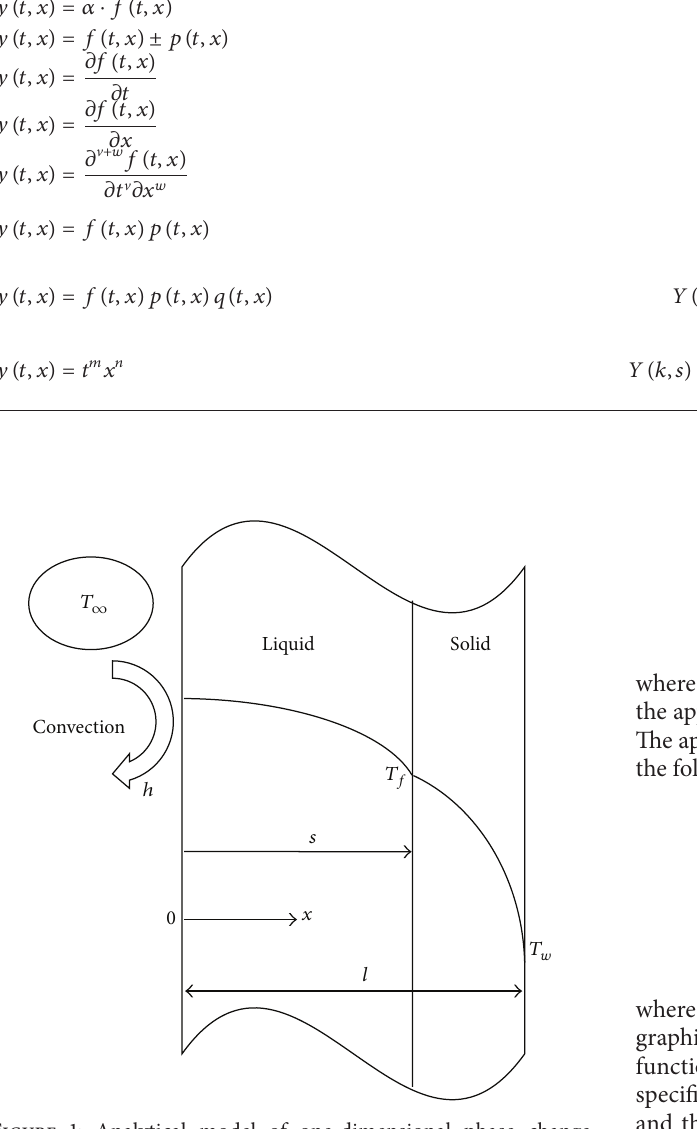
Figure 1: Analytical model of one-dimensional phase change process for a finite-thickness